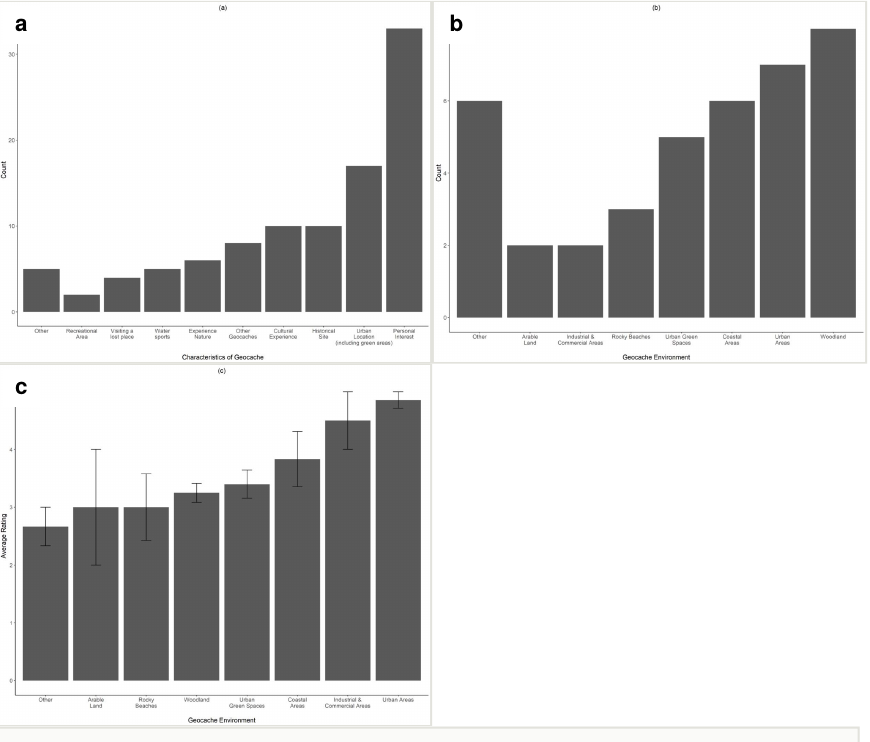
Figure 6 – Geocache placer questionnaire responses according to the (a) characteristics of the geocache, (b) the environment where the geocache was placed and (c) the average rating for the experience assigned to the geocache by the